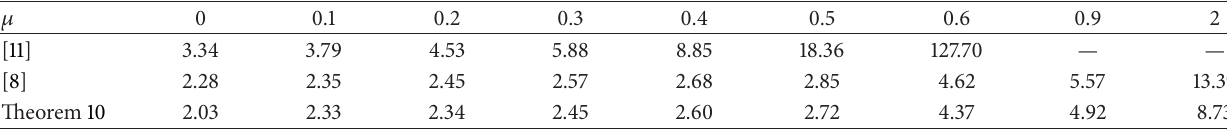
Table 3: Computed 𝛿 ’s of Example 1 for the case 𝜏 𝑚 ≤ 𝜏(𝑡) ≤ 𝜏 𝑀 , ̇𝜏(𝑡) ≤ 𝜇 with 𝜏 𝑚 = 0,𝜏 𝑀 = 0.75